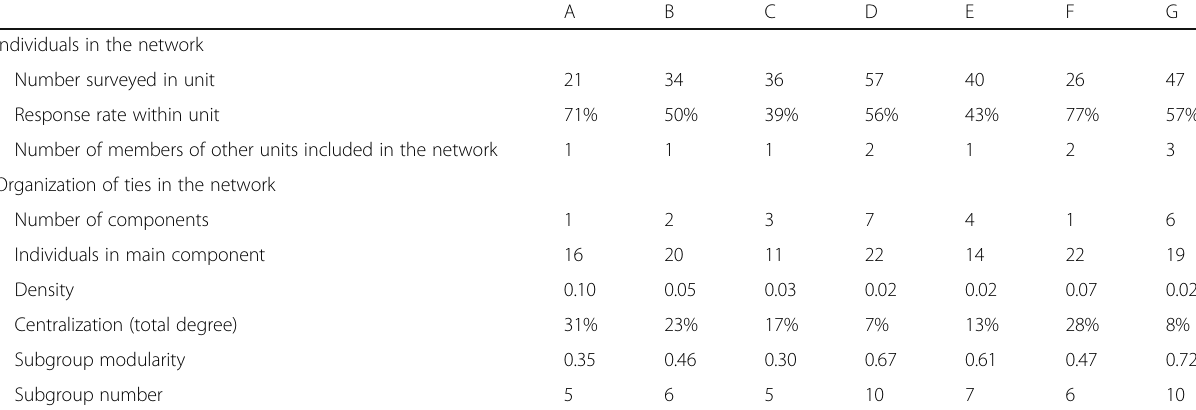
Table 3 Descriptive network values for each unit ’ s all-encompassing discussion network